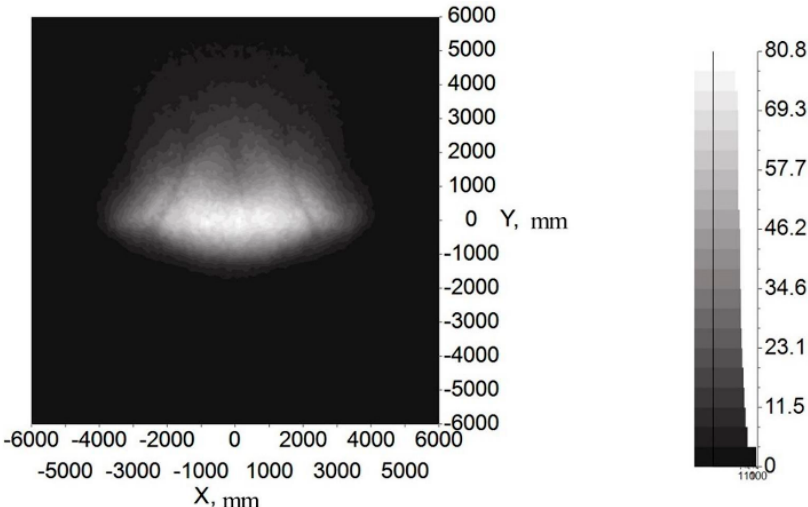
Figure 16. The illumination distribution of high beam with prism.